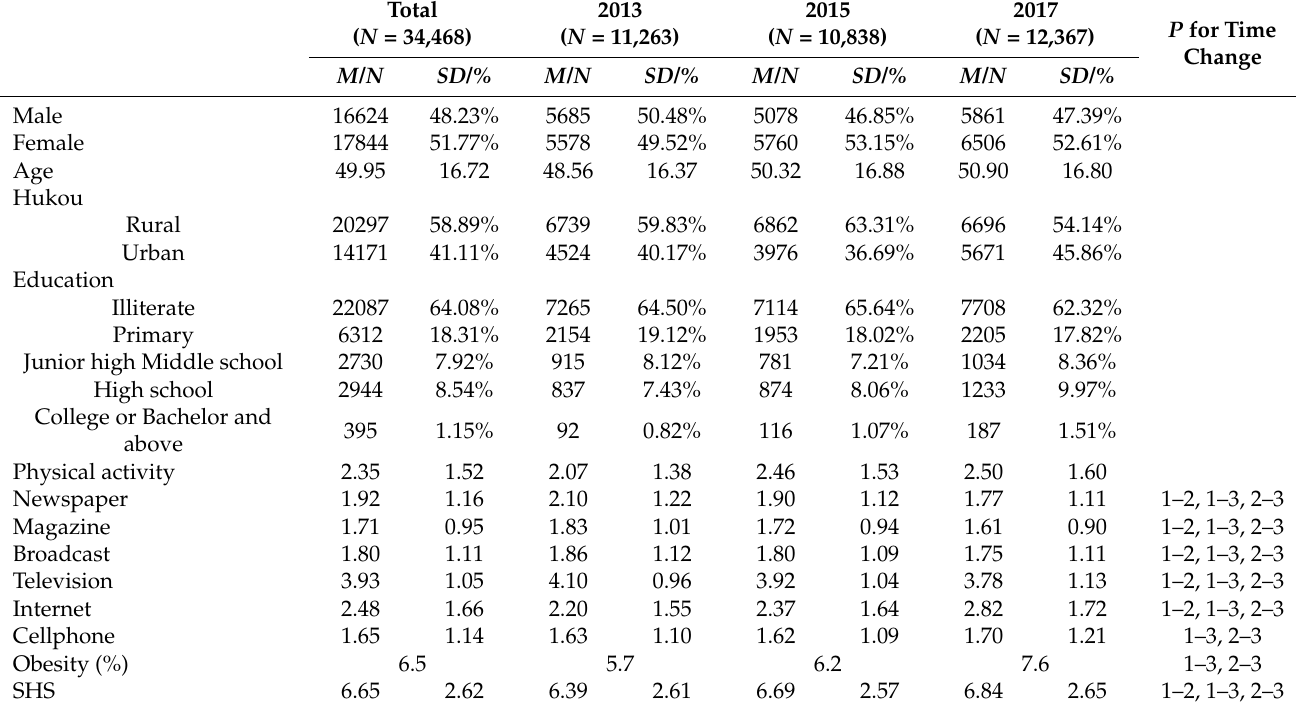
Table 1. Descriptive characteristics of demographics, media use, obesity, and SHS in 2013, 2015, and 2017.